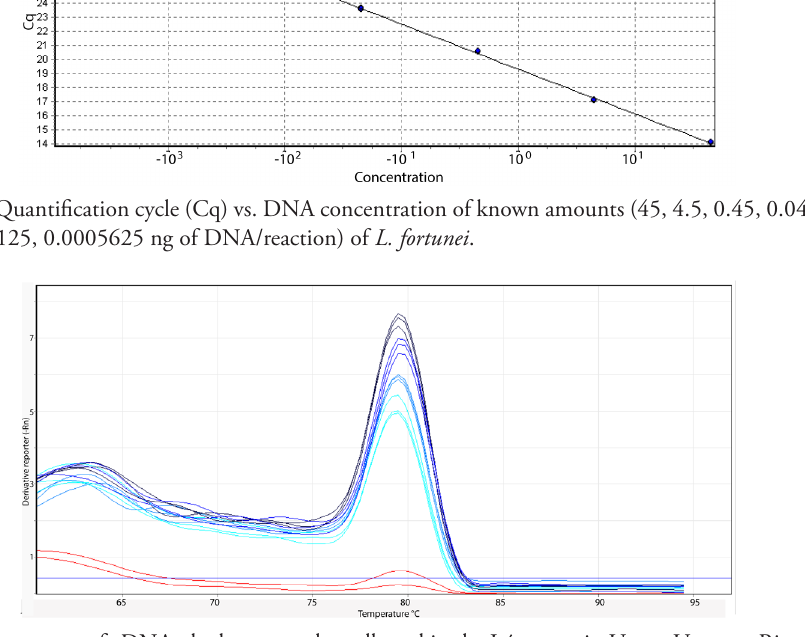
Figure 5. Melting curves of eDNA plankton samples collected in the Itá reservoir, Upper Uruguay River, Southern Brazil. Blue lines represent positive samples, and red lines represent a negative sample for L.